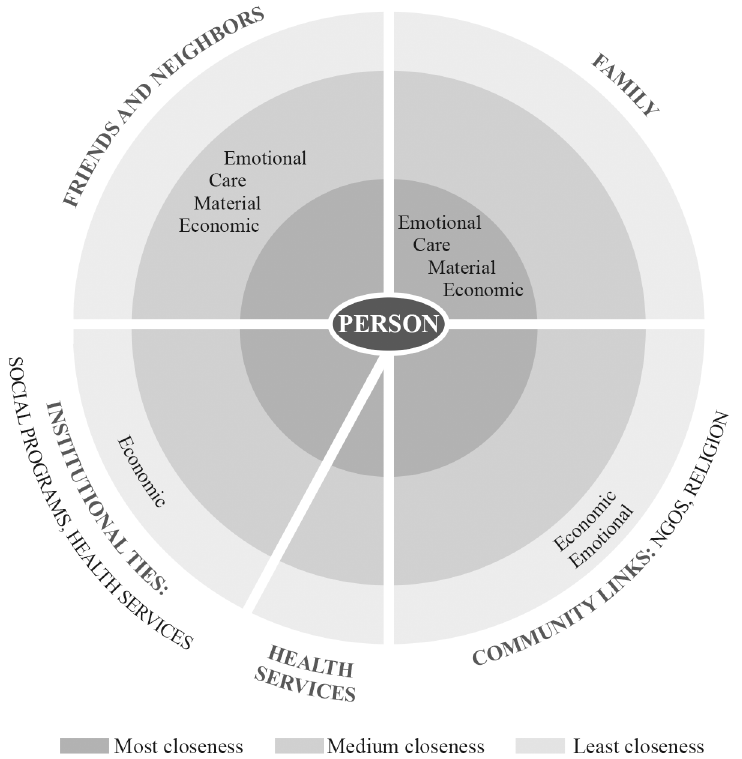
Fig 1. Providers of social support for patients with type 2 diabetes with economic